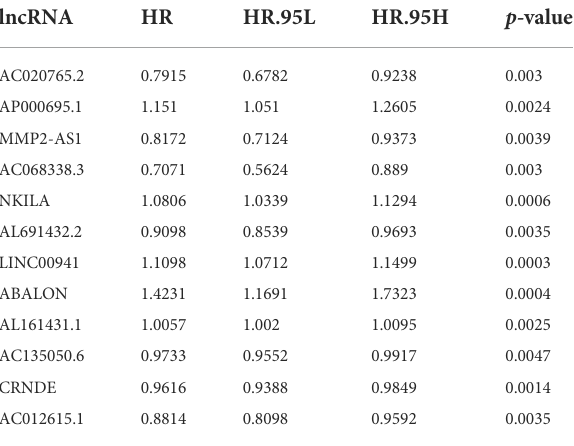
TABLE 1 The prognostic effect of autophagy-related lncRNAs by univariate Cox analysis.